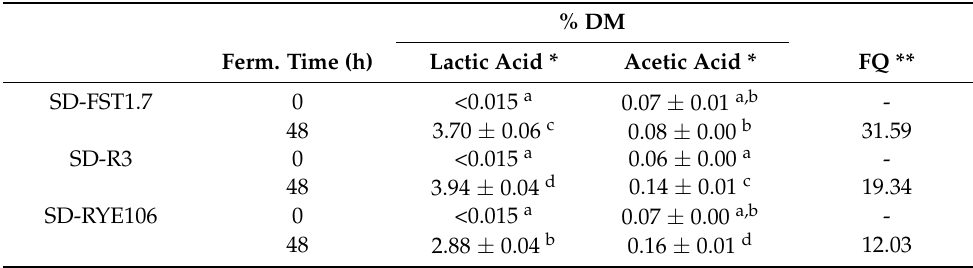
Table 3. Organic acids concentration (% dry ma tt er; % DM) and fermentation quotient (FQ) of sour- doughs inoculated with Lactiplantibacillus plantarum FST1.7 (SD-FST1.7), Lacticaseibacillus paracasei R3 (SD-R3), and Pediococcus pentosaceus RYE106 (SD-RYE106).